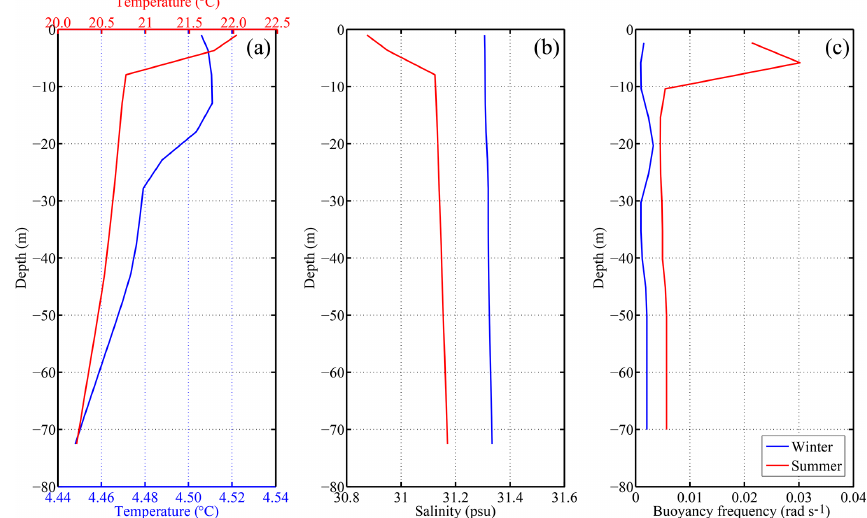
Figure 7. Horizontally homogeneous profiles of the initial (a) temperature, (b) salinity, and (c) buoyancy frequency used in the numerical experiments, in winter (blue solid lines) and in summer (red solid lines).